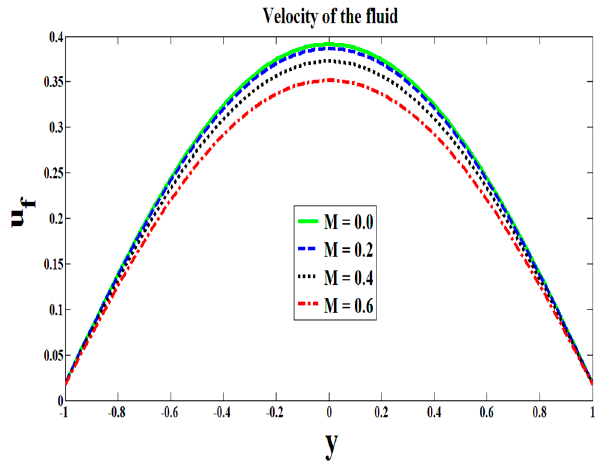
Figure 2. Effects of magnetic fields on the flow.